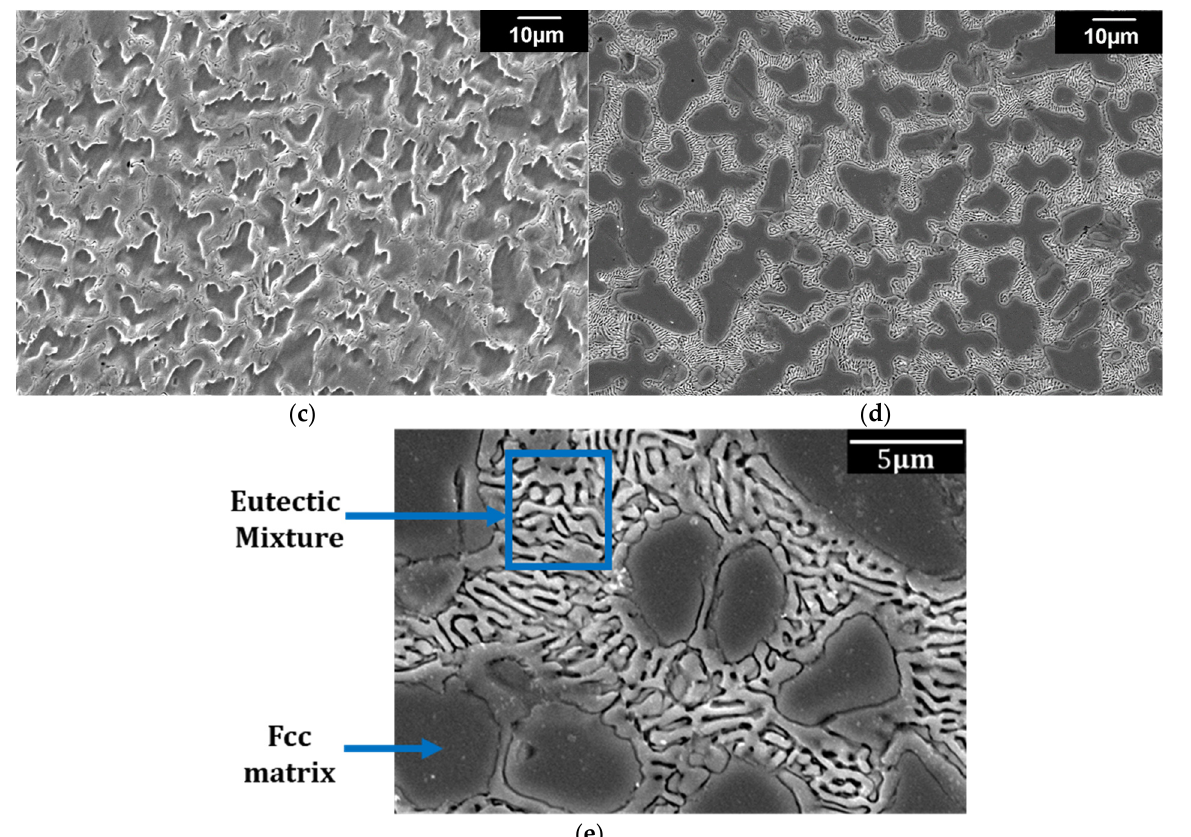
Figure 3. Scanning electron micrographs of developed HEAs: ( a ) CoCrFeNi-Mo 0.1 , ( b ) CoCrFeNi-Mo 0.25 , ( c ) CoCrFeNi-Mo 0.5 , ( d ) CoCrFeNi-Mo 1.0 , ( e ) CoCrFeNi-Mo 1.0 (higher magnification).